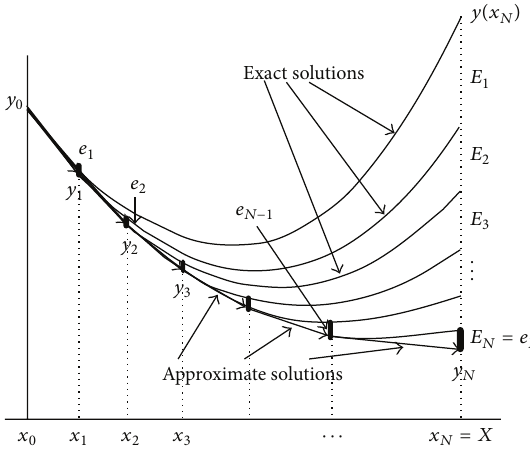
Figure 1: Global error estimation